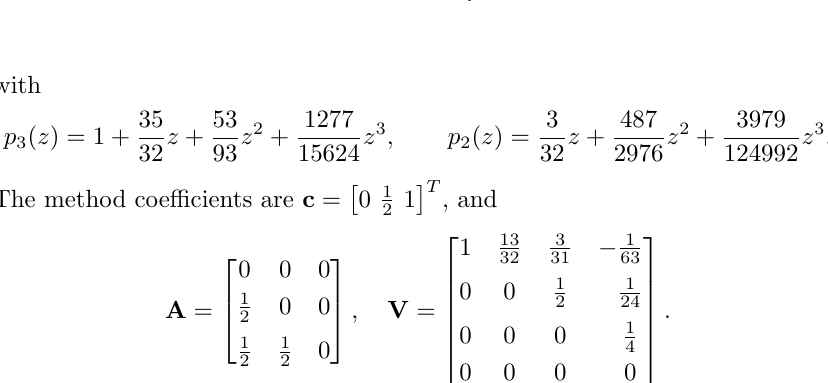
Figure 6. Stability regions of RK method of order p = 2 and GLMs with p = q = s = 2, r = 3 with IQS.